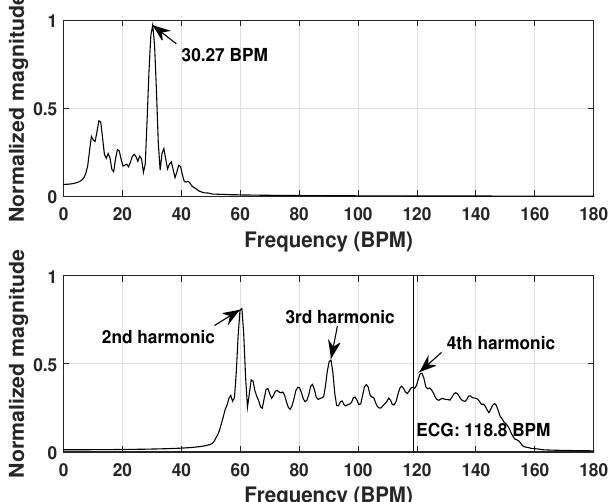
Figure 10. Respiration spectrum ( top ) and heartbeat spectrum ( bottom ) for test example